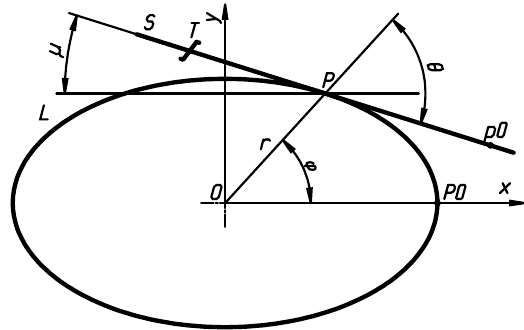
Figure 13. A reference rack guide over the roll line of a gear.